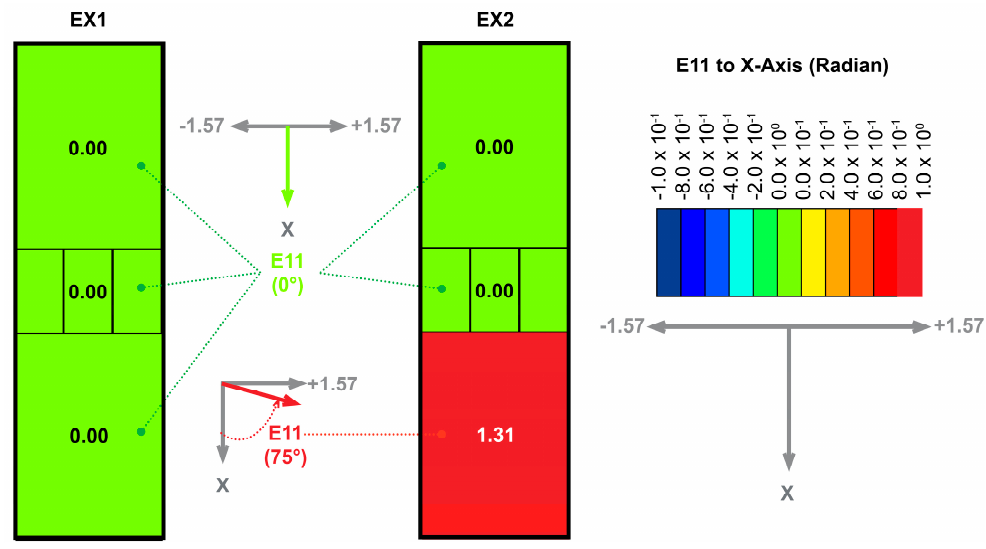
Figure 9. The two cases having the same grain sizes and shapes except for their grain orientations.